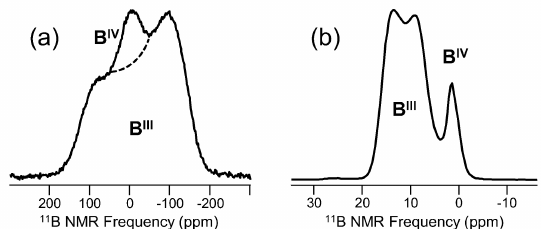
Figure 2. 11 B NMR data for a binary antimony borate glass with composition 40.8Sb 2 O 3 -59.2B 2 O 3 (mol %) [16], with permission from Society of Glass Technology. The wideline data in ( a ) were obtained at 4.7 T and are displayed in absorption mode, which differs from the original derivative spectra of Bray and other pioneers of glass NMR. The dashed line represents an approximate separation of the two NMR signals. The trace in ( b ) shows the 11 B MAS NMR spectrum measured at 11.7 T and is typical of most modern high-field NMR data for 11 B in glasses. In both spectra, the signals from boron in three-fold (B III ) and four-fold (B IV ) coordination are labeled. Note the very different frequency scales necessary to plot these